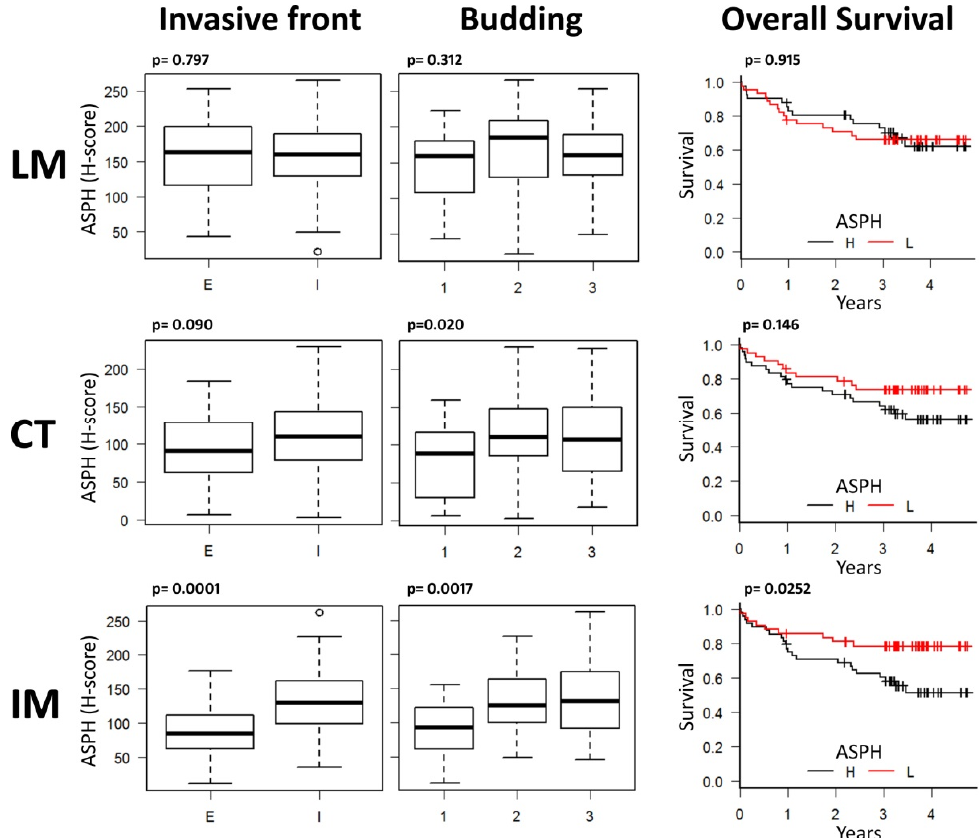
Figure 3. ASPH expression in the tumor invasive margin (IM) correlates with the pattern of local invasion and patients’ overall survival: invasive front type (I = infiltrative, E = expansive), tumor budding (1 = 0–4 buds, 2 = 5–9 buds, 3 ≥ 10 buds) and overall survival (L = low, H = high ASPH levels dichotomized by the median value) show a strong relation only with ASPH levels scored in CRC IM. Center of the tumor (CT)-scored ASPH shows a statistically significant relation only with tumor budding, while ASPH expressed next to tumor lumen (LM) does not show any relation with these parameters. Box plots represent the quartile distribution of ASPH H-score quantifications in CRC samples around the median value. Statistics are reported in each graph as the calculated p value (Invasive front: Student t -test; Budding: one-way ANOVA; Overall survival: Kaplan–Meier